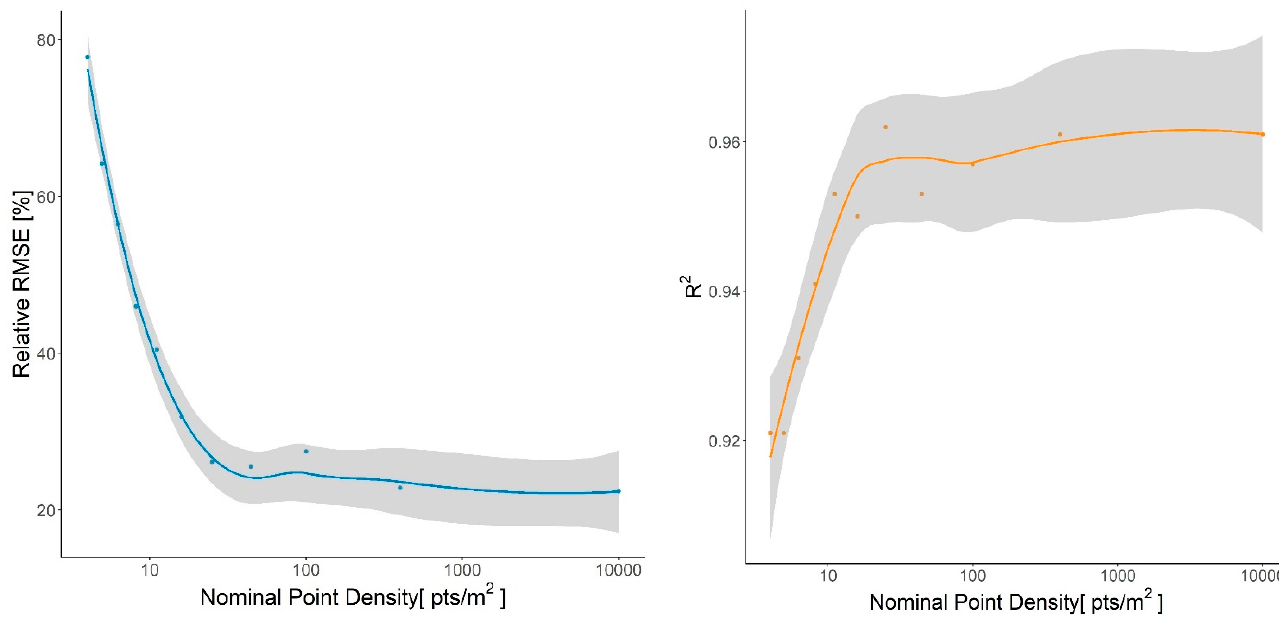
Figure 8. Relative root mean square error ( left ) and coefficient of determination ( R 2 ) ( right ) values for above ground biomass predictions of the multiple regression power model made using the product of height and crown area derived from varying nominal point densities. Results are fitted with a loess (locally weighted smoothing) line to show trends. Grey areas show the 0.95 confidence interval for these